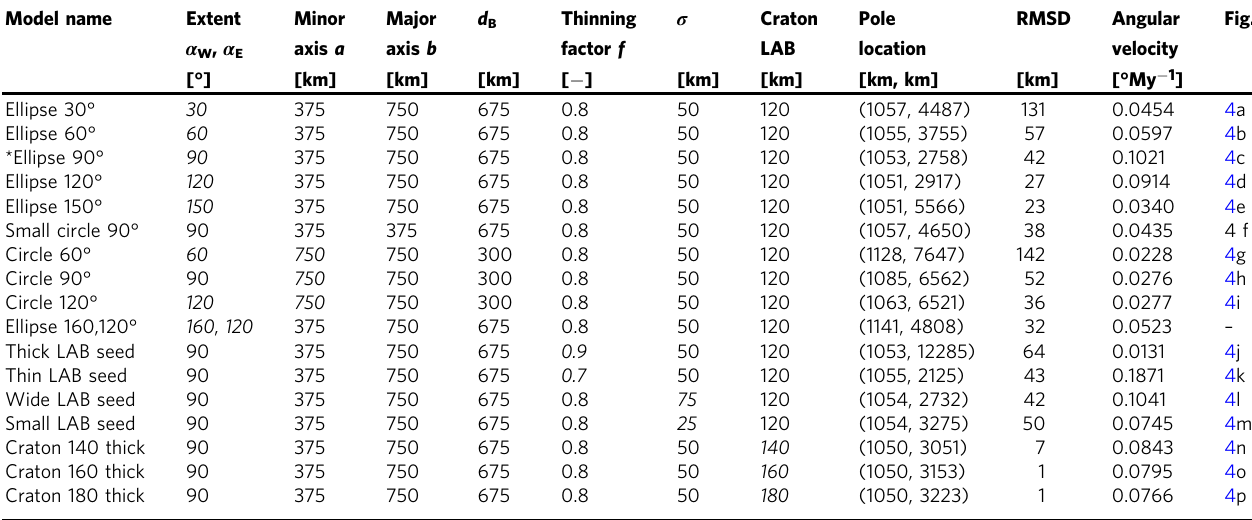
Table 1 Predicted rotation poles relative to the western plate after 10 My for different controlling parameters of the generic model setup.